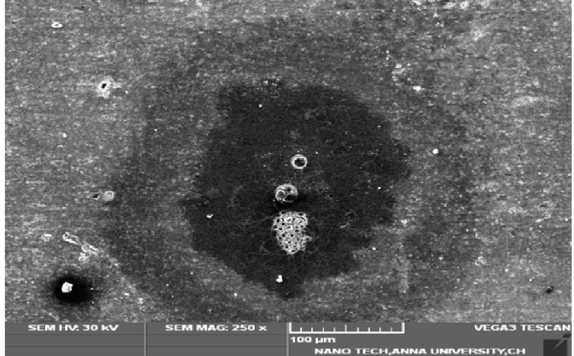
Figure 4: Corroded surfaces of Al/GO